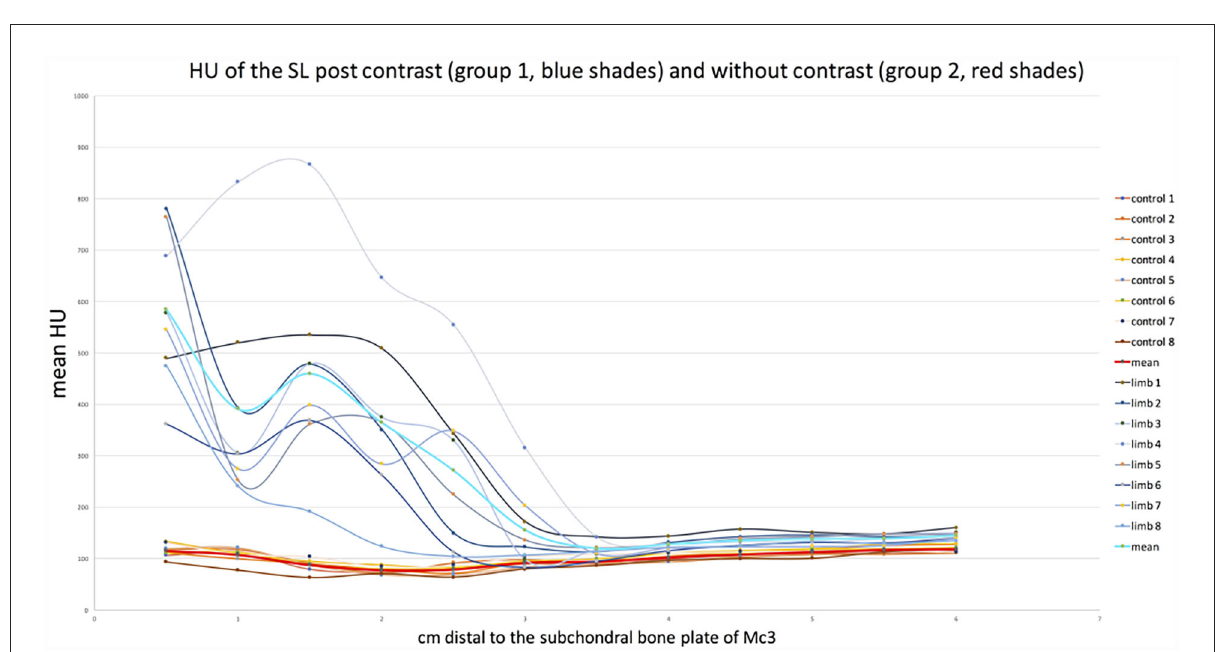
FIGURE3 Graph showing the change in mean HU values at each level of both groups. Graphs in blues shades (group 1, with contrast) show the significantly higher values in the proximal region (0.5–2.5cm) than distally (3–6cm). The graphs in red shades (group 2, control) show a flat course with similar values on both sides of the dotted